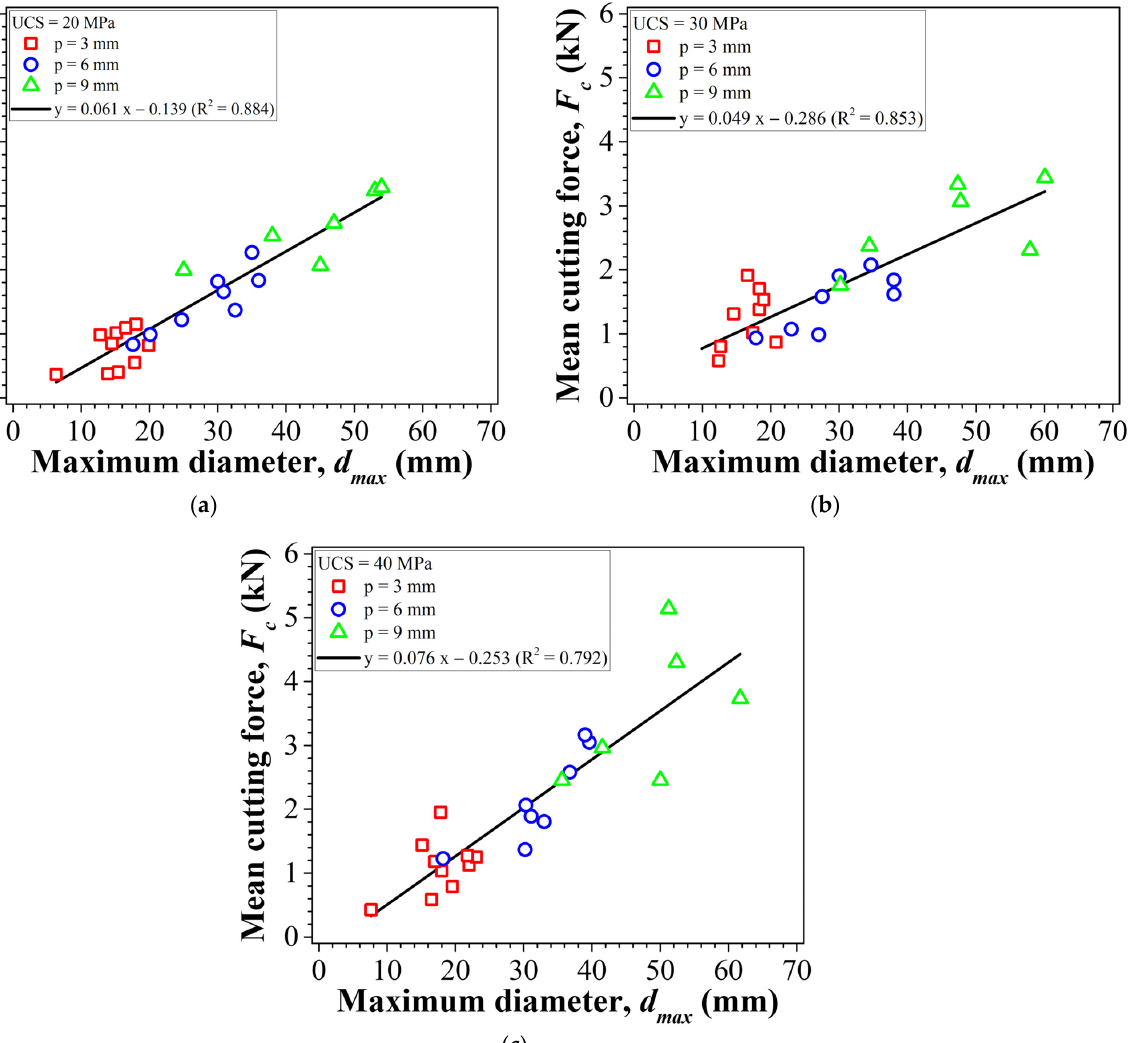
Figure 12. Relationship between maximum diameter and mean cutting force: ( a ) rock of UCS 20 MPa; ( b ) rock of UCS 30 MPa; ( c ) rock of UCS 40 MPa.